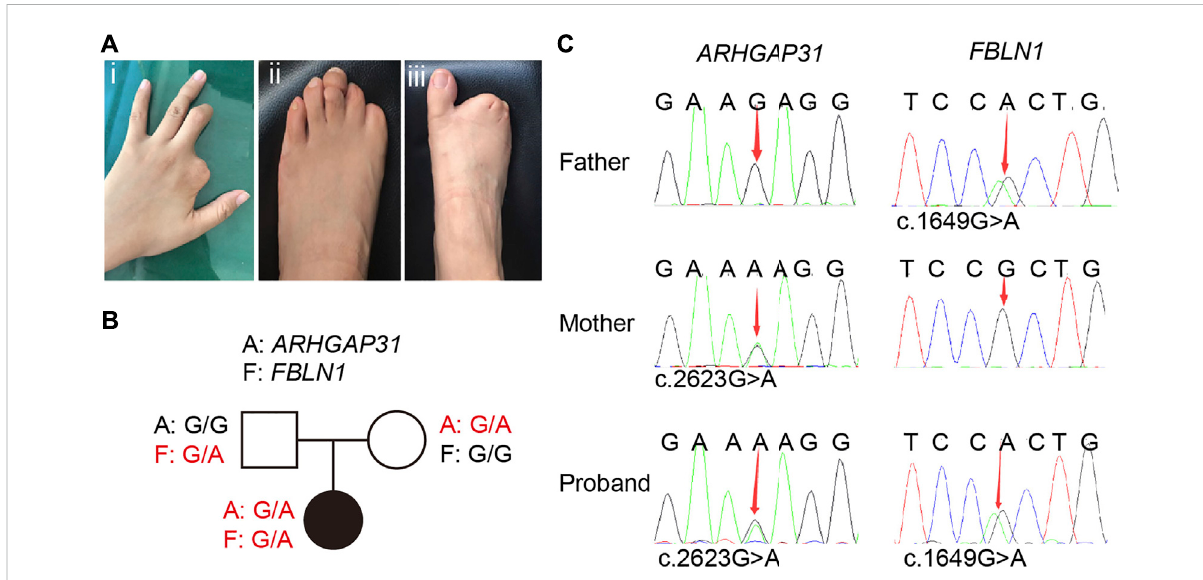
FIGURE 1 Clinicalmanifestationsintheprobandandrelatedsequencinginformation. (A) Defectsofthedistaldigits.(i)Second fi ngeriscompletelyabsent, the middle and distal phalanges of the left third fi nger are missing; (ii) distal limb reduction appeared on the left foot in the fi rst and second left toe with hypoplastic toenails on the third and fi fth toes; (iii) her second, third, fourth, and fi fth toes of the right foot are cutaneous syndactyly. (B) Family pedigree of the proband. (C) Sanger sequencing of the family members revealed inheritance of gene variants from her